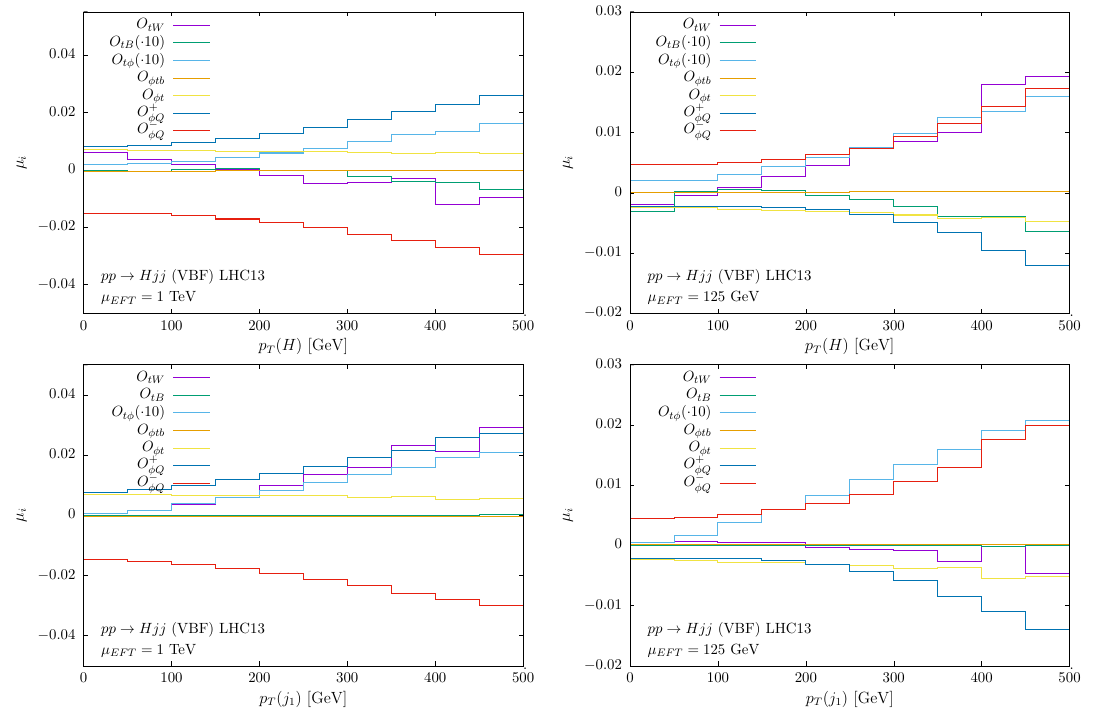
Figure 6 . Sensitivity of the Higgs (top) and hardest jet (bottom) transverse momentum dis- tribution in VBF Higgs production for the di(cid:11)erent operators at (cid:22) EFT = 1000 GeV (left) and (cid:22) EFT = 125 GeV